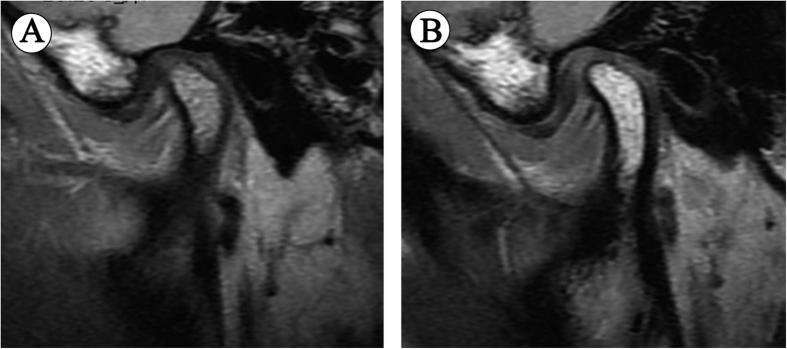
MRI scans of a 16-year-old female ADDWR patient with the interval of 21 months, showing almost unchanged disc status.(A) First visit, (B) Follow-up visit.